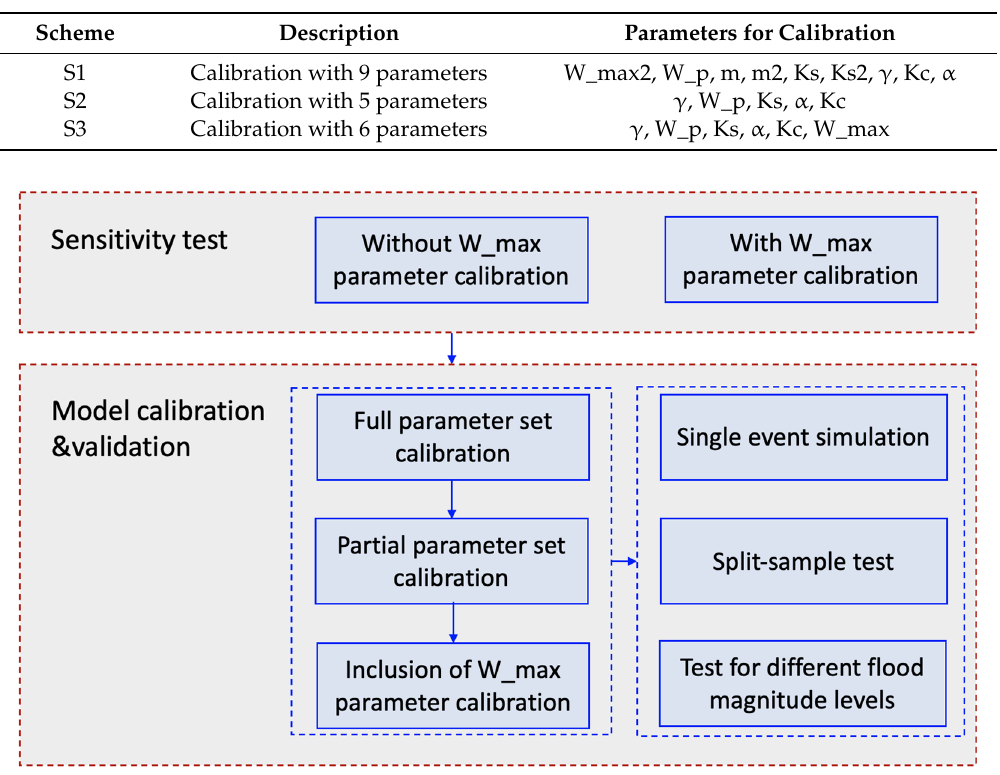
Figure 4. Flowchart of this study. Table 4. Calibration schemes using the MISDc-2L model.